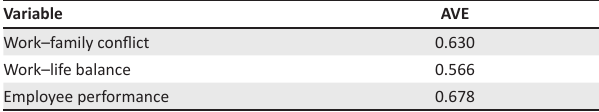
TABLE 5: Composite reliability and Cronbach’s alpha calculation results.